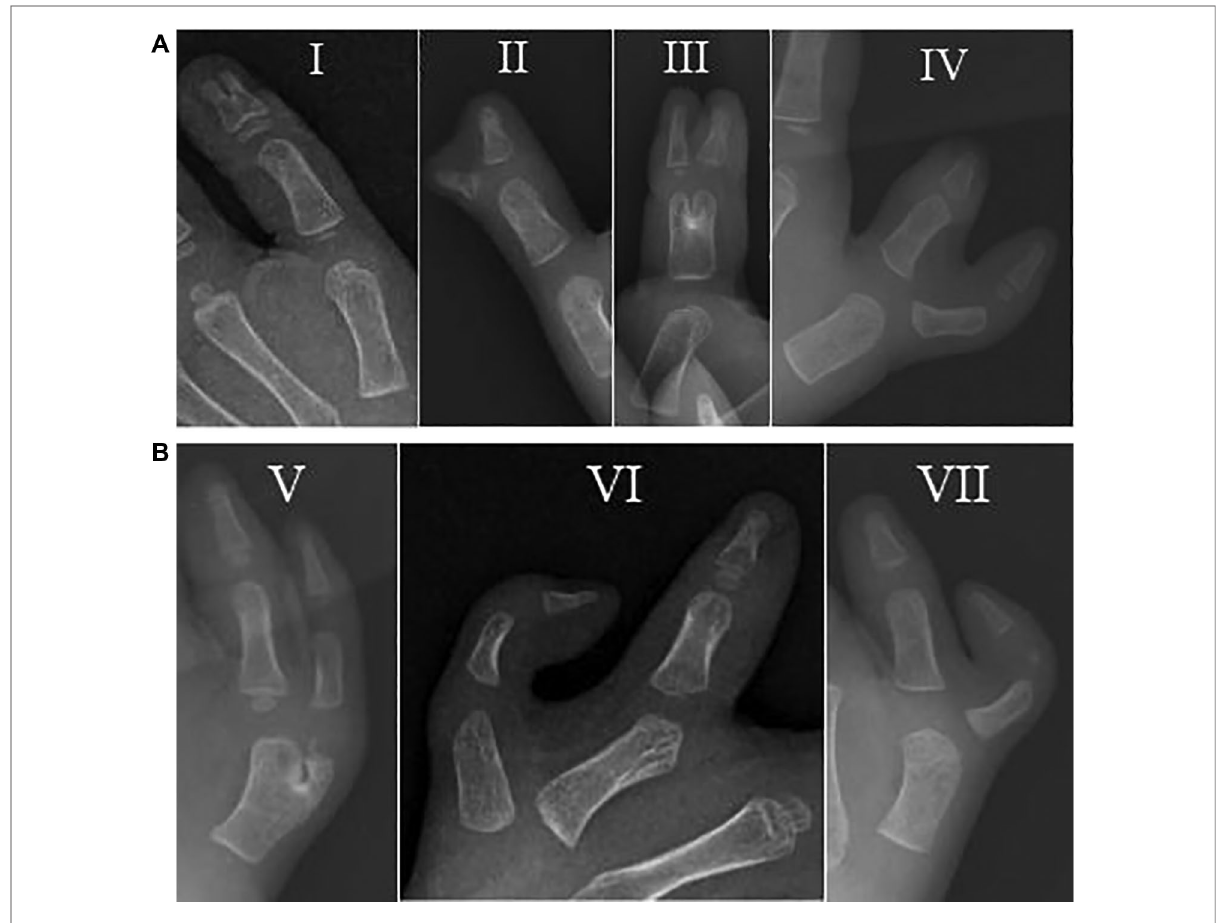
FIGURE 2 ( A,B) Radiograph of the Wassel-Flatt classi fi cation: ( A ) type I, II, III and IV; ( B ) type V, VI and